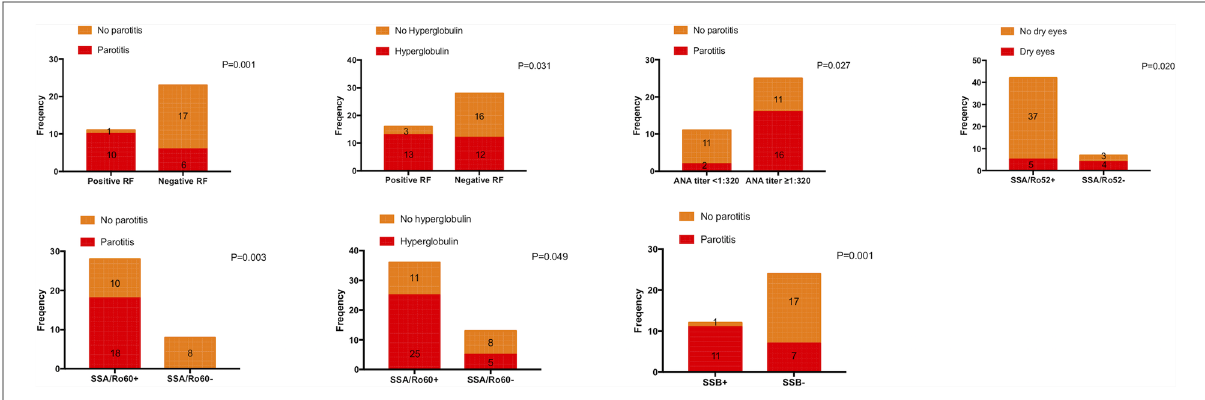
FIGURE 1 Clinical features associated with patients with positive SSA/Ro52, positive SSA/Ro60, and positive SSB. ANA, anti-nuclear antibodies; SSA/Ro52, anti- Ro52/SSA antibodies; SSA/Ro60, anti-Ro60/SSA antibodies; SSB, anti-Ro/SSB antibodies; RF, rheumatoid factor.